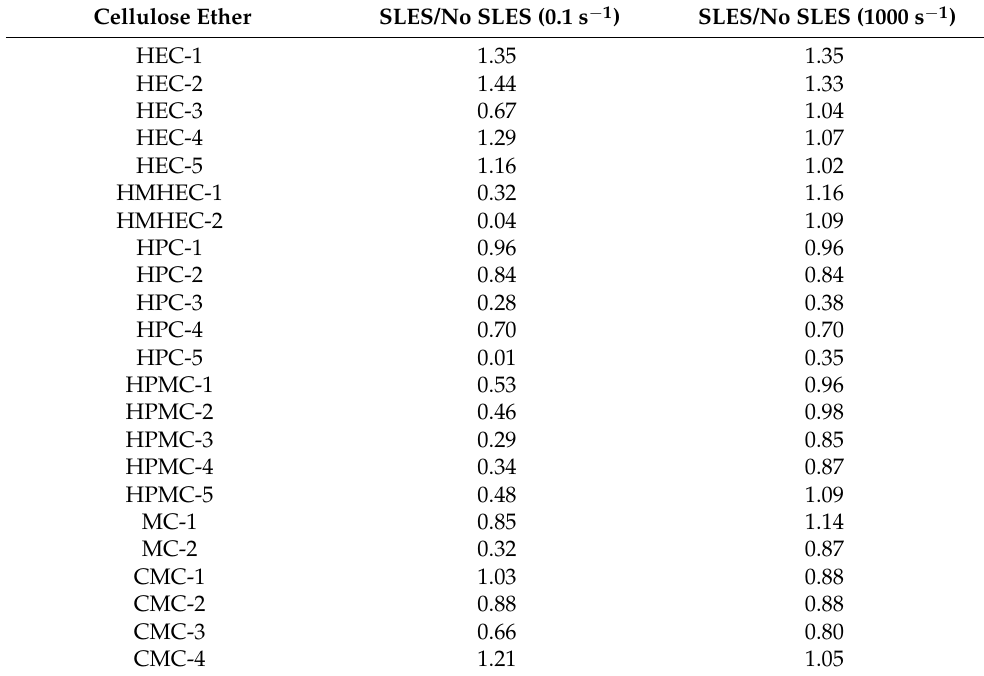
Table 3. Ratio of the viscosity of the polymer solution containing surfactant (SLES) to the polymer solution without surfactant at two shear rates for the tested cellulose